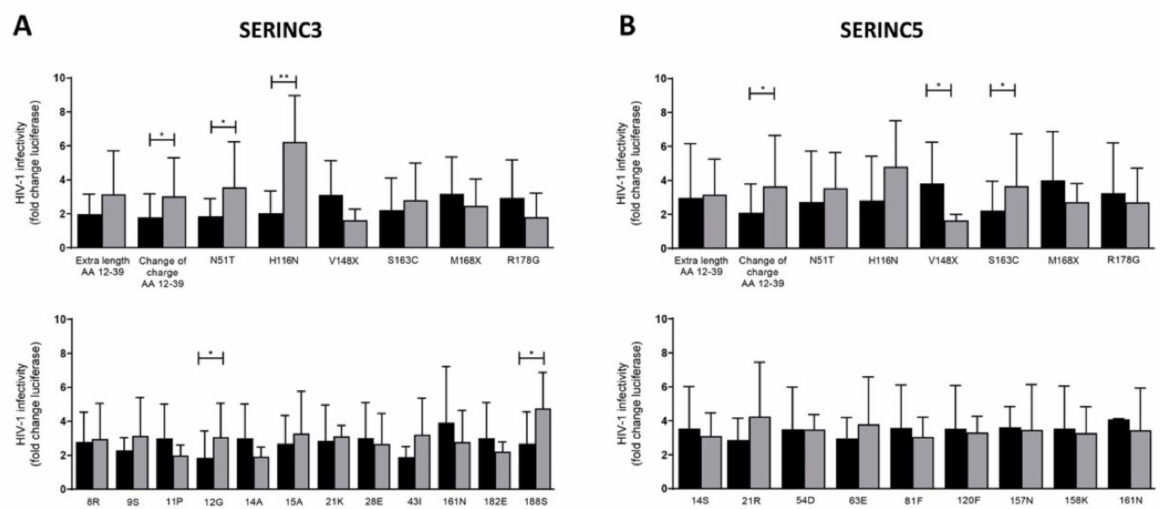
Figure 5. Effect of naturally occurring mutations in Nef on HIV-1 infectivity. The ability of primary Nef proteins that do or do not contain the indicated amino acids or mutations to counteract ( A ) SERINC3- or ( B ) SERINC5-mediated HIV-1 restriction was compared. Virus infectivity is expressed relative to the virus produced in the presence of NL4-3 Nef (fold change of three independent experiments). Means ± SD of Nef proteins containing the indicated amino acid or mutation are given. Mann–Whitney U test (* p < 0.05; ** p < 0.01). Black bar: indicated amino acid or mutation is absent; grey bar: indicated amino acid or mutation is